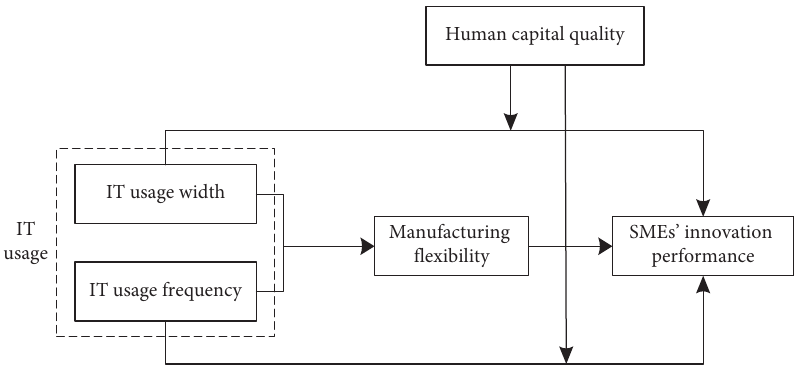
Figure 1: Research